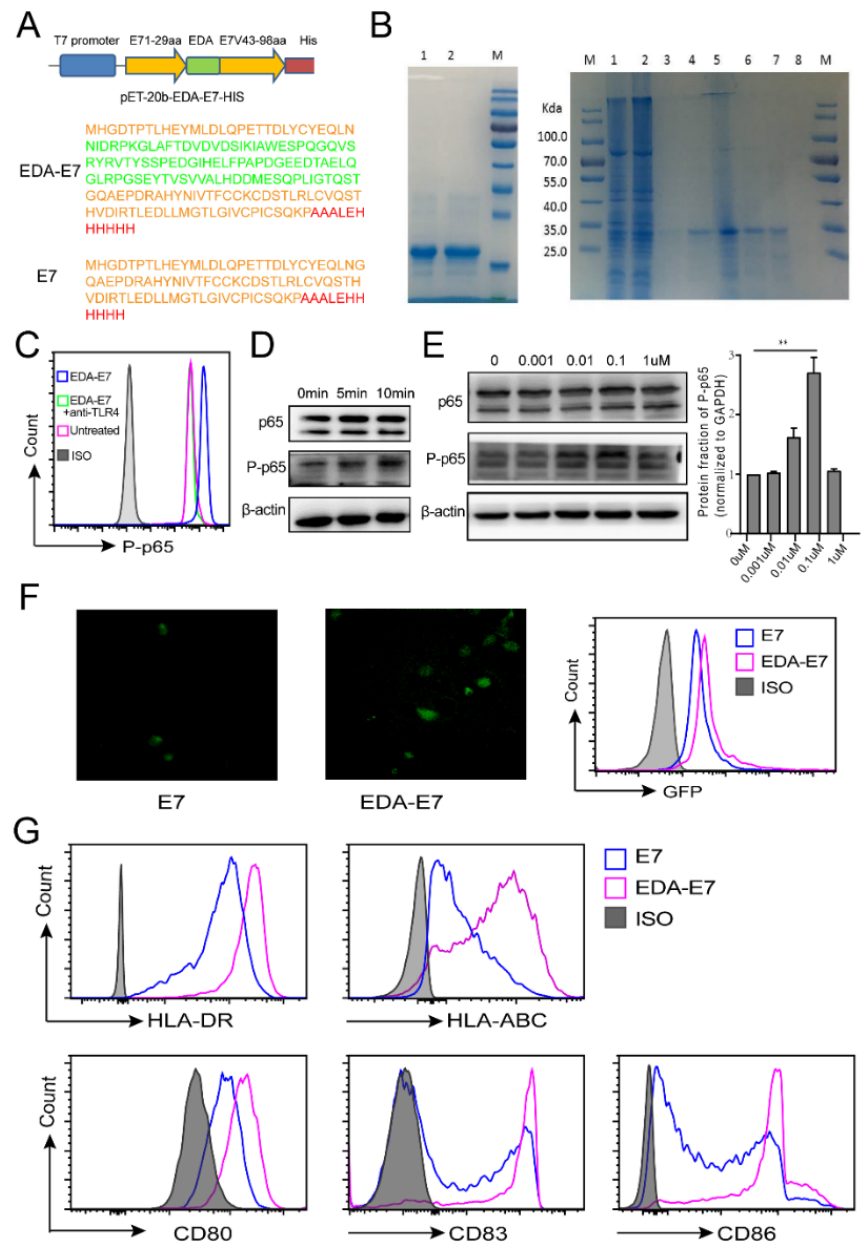
Figure 2. Recombinant fusion protein EDA-E7 activates DCs through TLR4. Schematic diagram showing pET-20b-EDA-E7-His plasmid design as well as protein sequence of fusion protein EDA-E7 and E7 ( A ); SDS-PAGE Coomassie brilliant blue staining for E7and EDA-E7. Left lane 1 and 2: E7 recombinant protein after purification, protein marker size is as right panels. Right lane 1: sample before purification, lane 2: sample of flow-through, lane 3: 1% imidazole elution, lane 4: 2% imidazole elution, lane 5: 5% imidazole elution, lane 6: 50% imidazole elution, lane 7: 100% imidazole elution, lane 8: elution control ( B ); flowcytometry for P-p65 with or without TLR4 blockade after EDA-E7 treatment ( C );Western blotting for p65, P-p65 at different time point after THP-1 treatment of 100nM EDA-E7 or E7 ( D ); Western blotting for p65, P-p65 upon stimulation with different dose of EDA-E7 protein and the quantification graph (n = 3 per group) ( E ); Fluorescent image and flow cytometry for E7, EDA-E7 binding with DCs ( F ); Flow cytometry for HLA-DR HLA-ABC, CD80, CD83, CD86 expression on DCs after stimulation with EDA-E7 or E7 ( G ), ISO: isotype control, ** p <